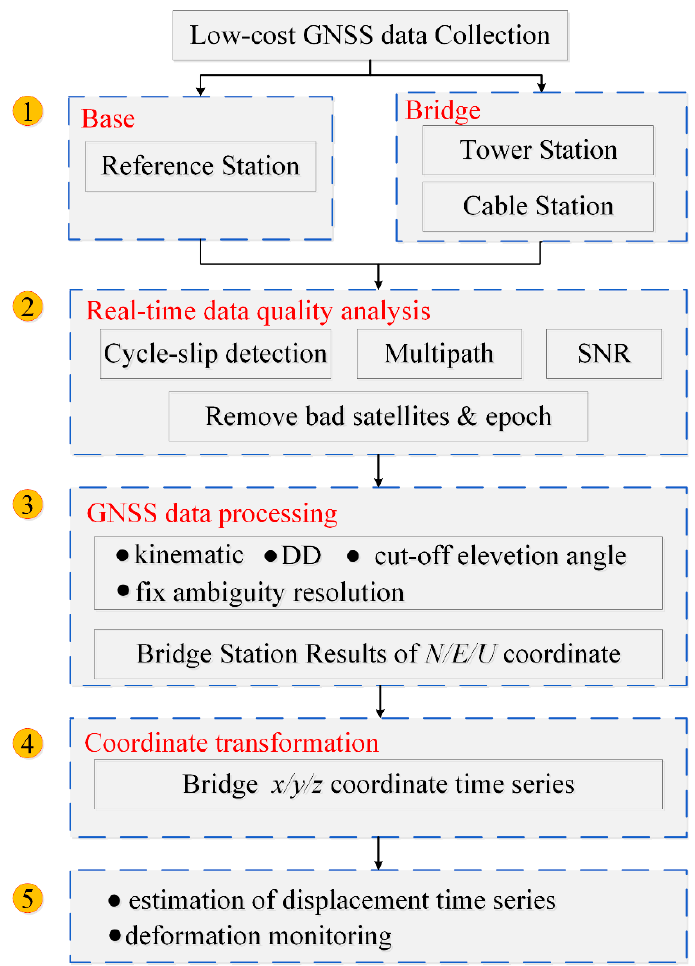
Figure 22. The method flowchart for Guojiatuo Suspension Bridge using low-cost GNSS sensors.